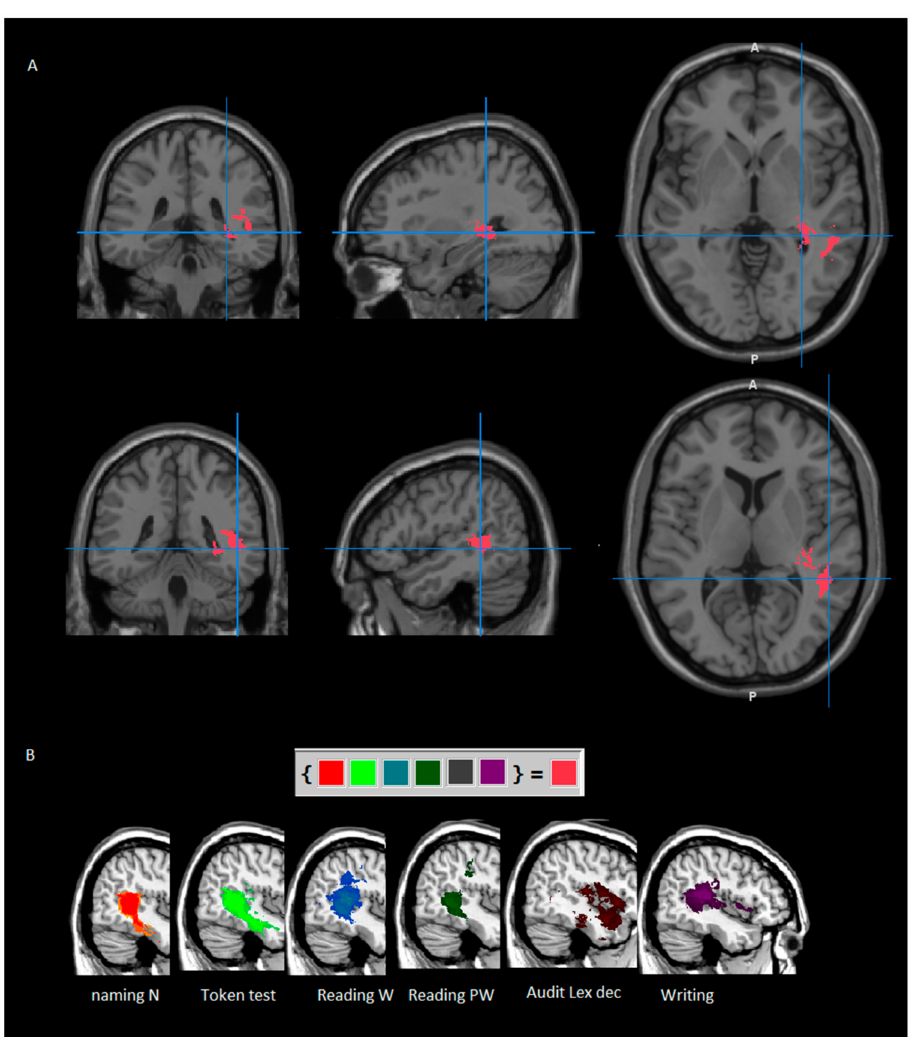
Figure 3. Intersection ( A ) of lesion masks of the different tasks ( B ). MR images are displayed following radiological convention (left is right and vice versa). N = nouns; W = words; PW = pseudowords; Audit lex dec = auditory lexical